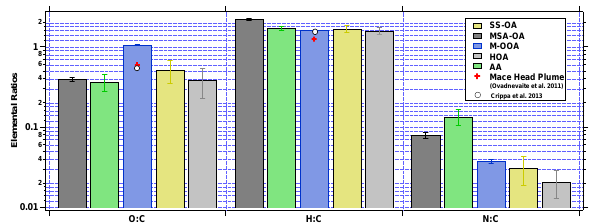
Fig. 18. Elemental ratios for each PMF-derived OA species based on HR PIKA analysis on the time interval as indicated in Fig. 5b.